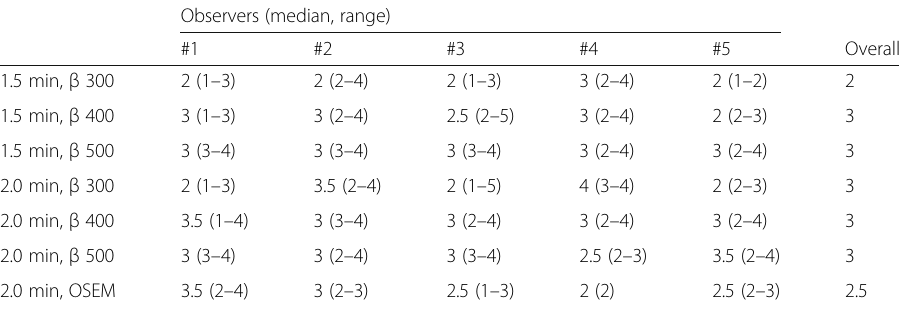
Table 2 Assessment of image